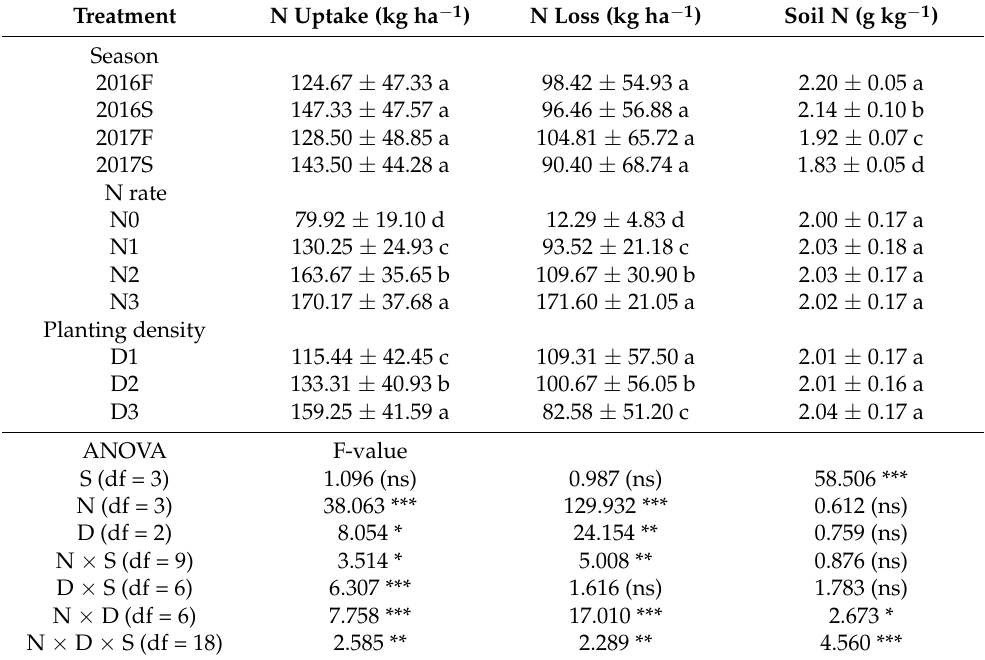
Table 2. N uptake and loss of perennial rice under different N rates and planting densities over four successive seasons of